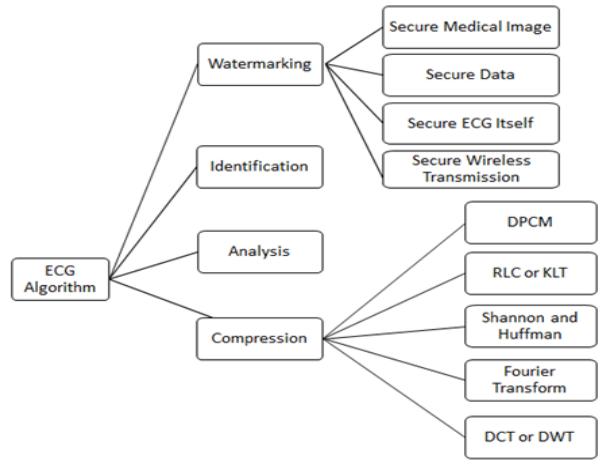
Figure 1. Related